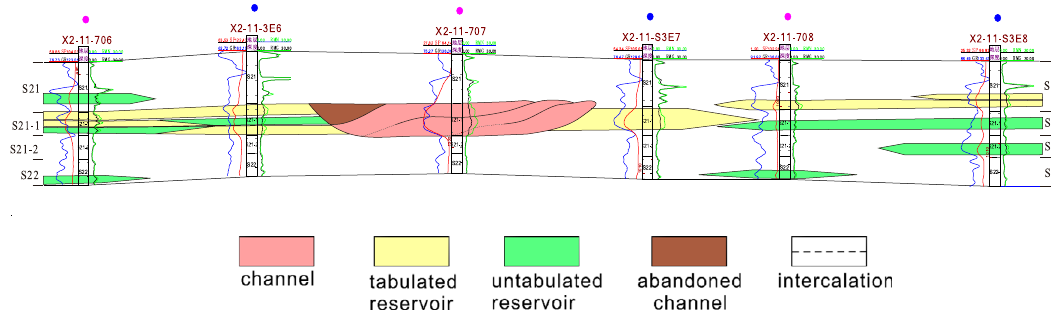
Fig. 3 Profile 1 of reservoir architecture set in study area